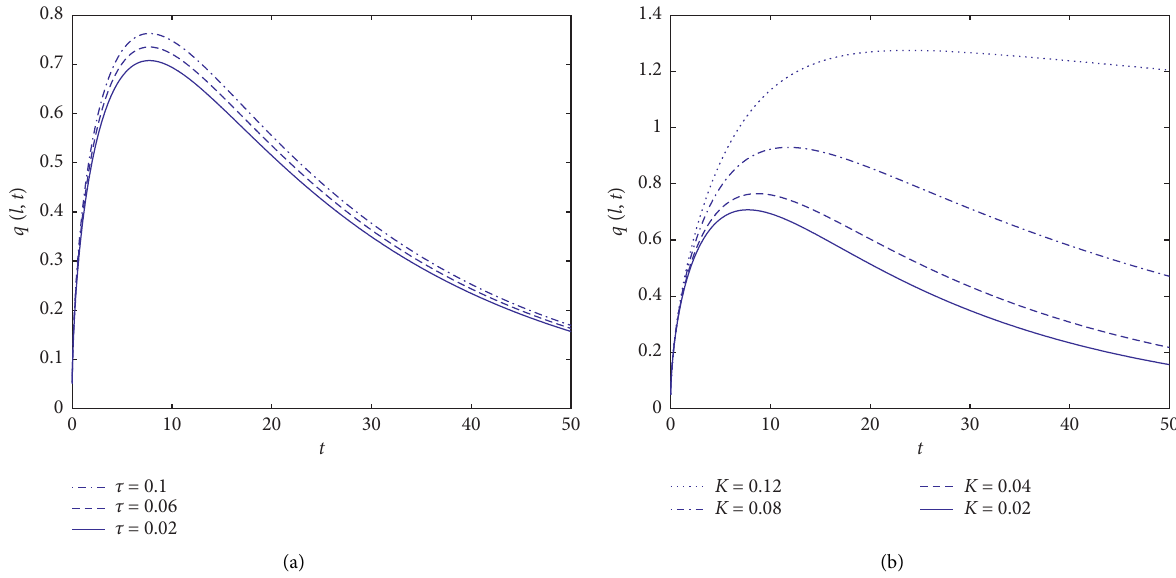
Figure 2: (a) q ( ℓ , t ) vs. time when b ( x ) � ( x / π ) − 1, q ( x, s ) � ( 1 + s ) sin ( x /2 ) , α � 0 . 4 , β � 0 . 1 , κ � 0 . 02, and for different values of τ . (b) q ( ℓ , t ) vs. time when α � 0 . 4 , β � 0 . 1 , τ � 0 . 02, and for different values of κ .